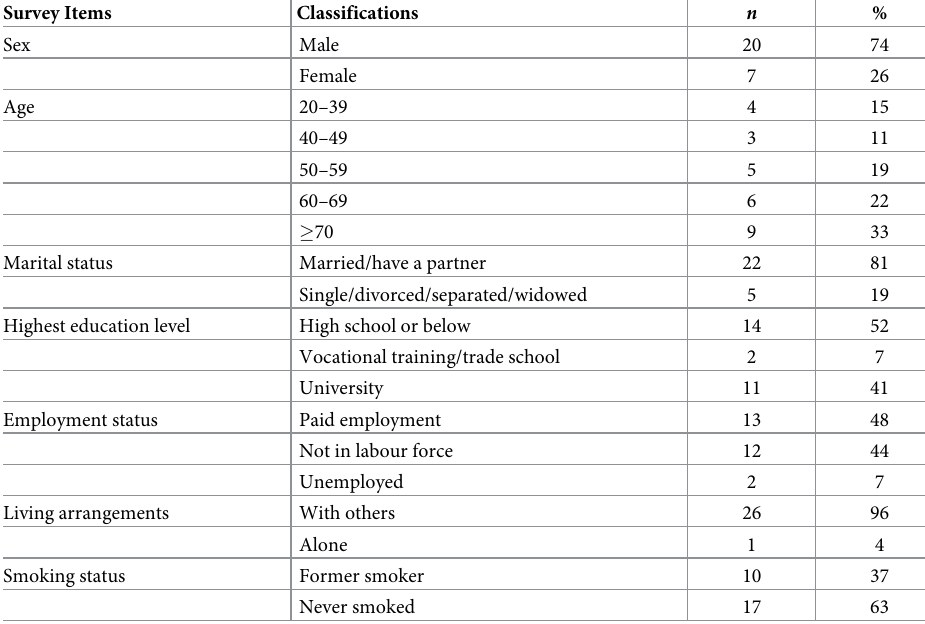
Table 1. Demographic characteristics of